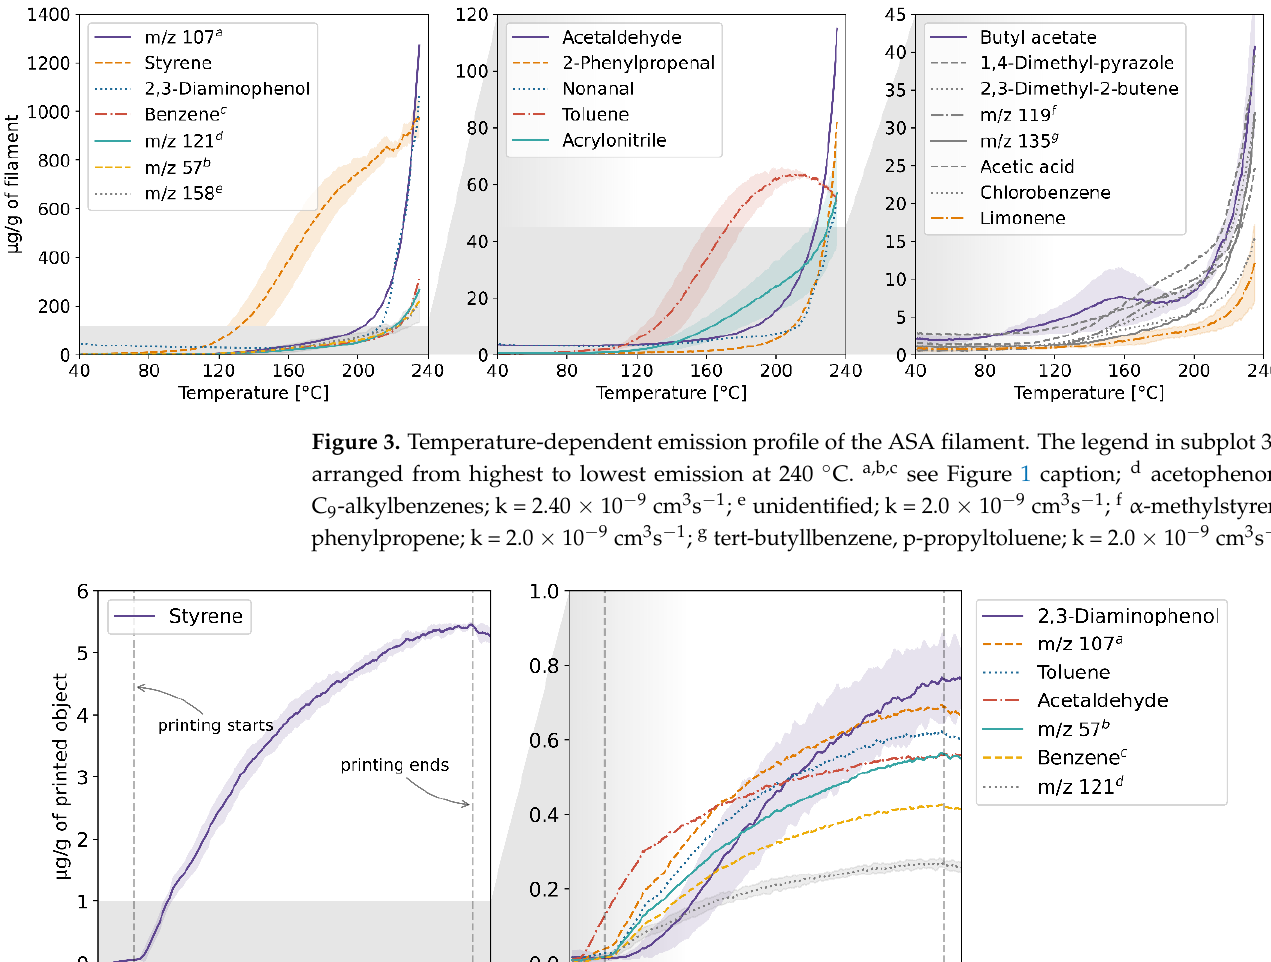
filament. a,b,c see Figure 1 caption.